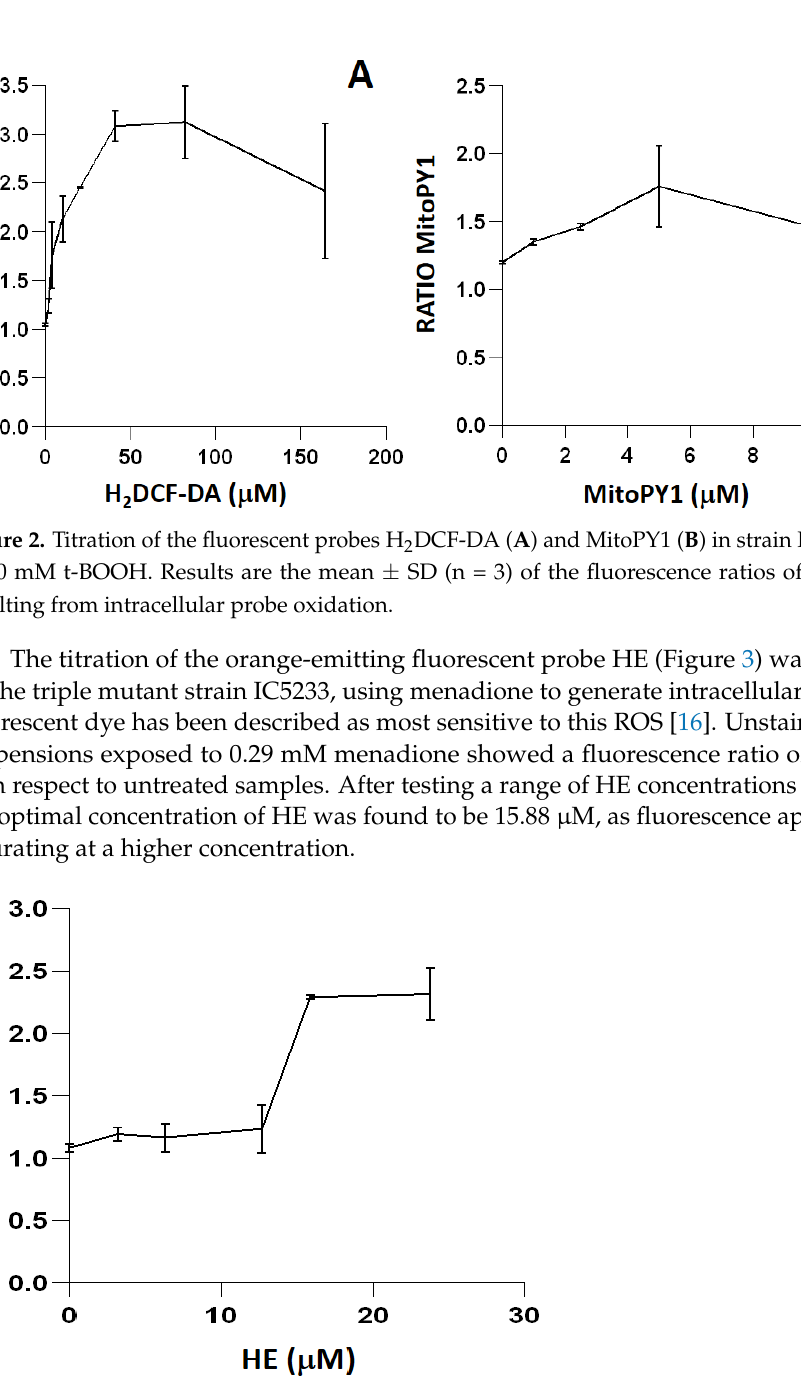
Figure 2. Titration of the fluorescent probes H 2 DCF-DA ( A ) and MitoPY1 ( B ) in strain IC188 exposed to 10 mM t-BOOH. Results are the mean ± SD (n = 3) of the fluorescence ratios of the products re- sulting from intracellular probe oxidation.